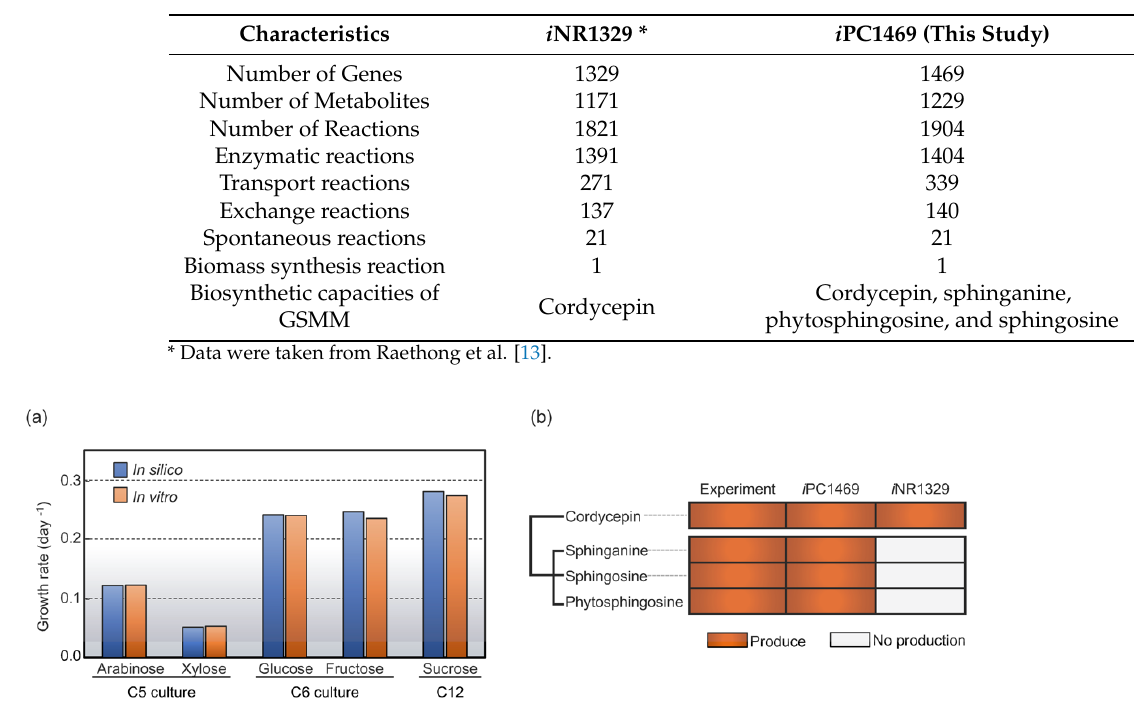
Table 2. Comparative metabolic characteristics of the genome-scale models of C. militaris .